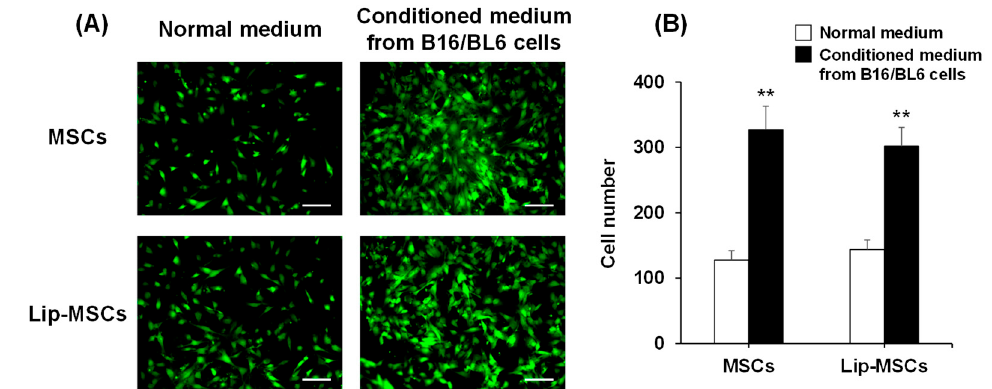
Figure 6. In vitro migratory activity of Lip-MSCs. ( A ) Representative photographs of non-loaded MSCs or Lip-MSCs migrated through the membrane pores toward the normal medium or condi- tioned medium from B16/BL6 cells. Scale bar: 100 µm. ( B ) The migrated cell number of non-loaded MSCs or Lip-MSCs. Each value represents the mean + SD ( n = 3). ** p < 0.01, compared with the normal